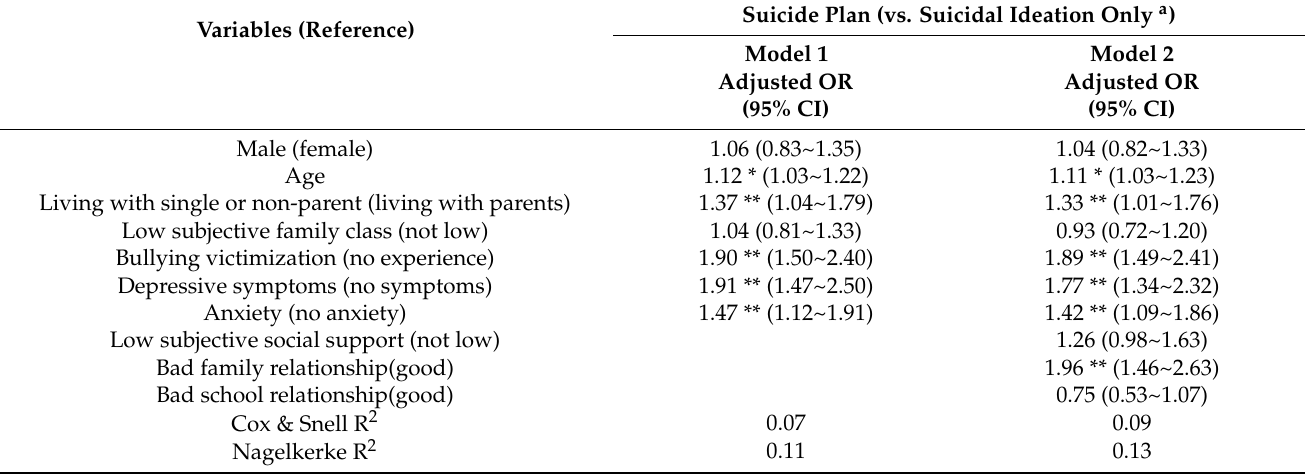
Table 3. Factors associated with suicide